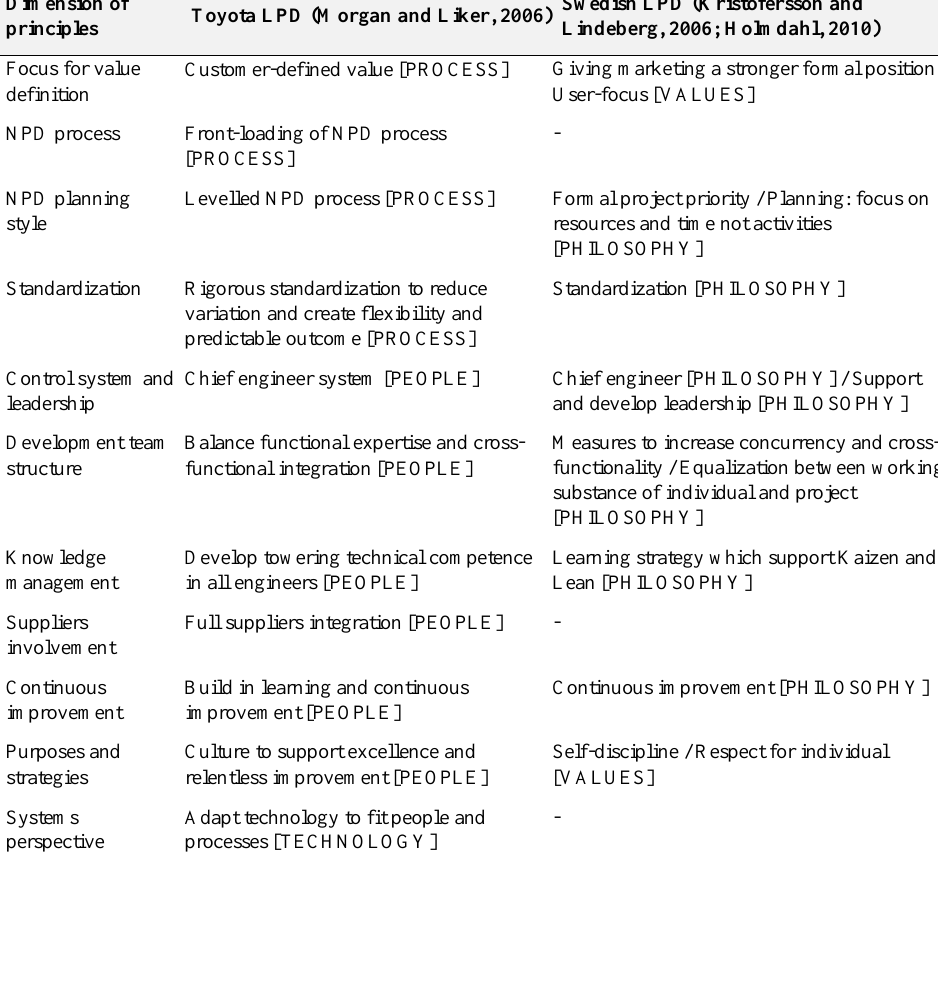
Table 1 – Comparison between Toyota and Swedish LPD principles in